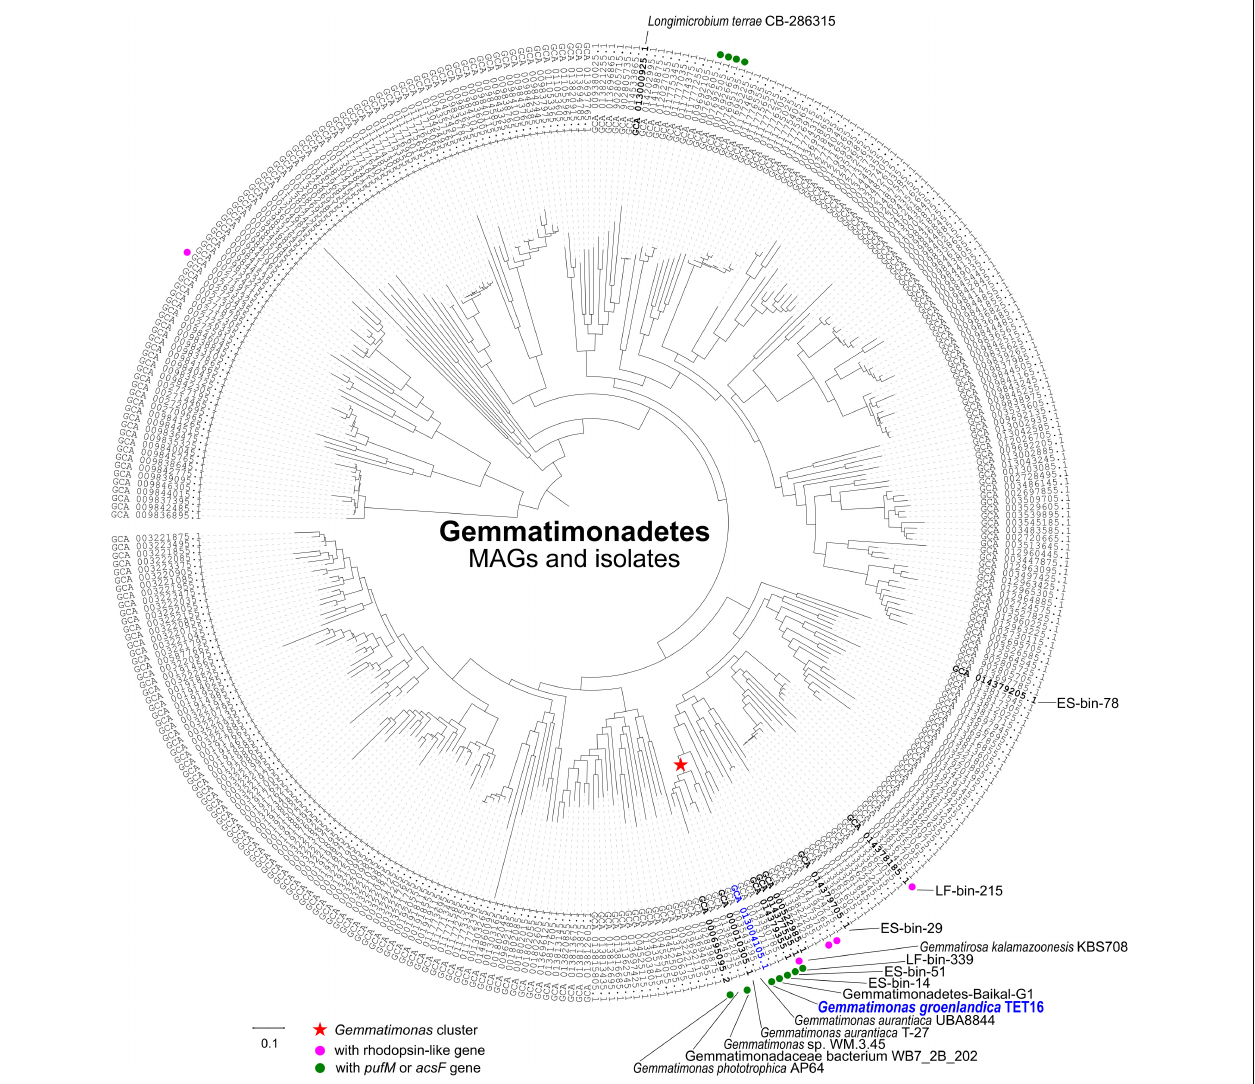
FIGURE 3 | A maximum likelihood phylogenomic tree of the metagenome-assembled genomes (MAGs) and isolates of the phylum Gemmatimonadetes based on aligned 36,076 amino acid positions from 400 most universal marker genes (see section “Materials and Methods”). All 364 Gemmatimonadetes genomes were downloaded from the NCBI microbial genomes portal. The tree was rooted with the genome of Fibrobacter succinogenes strain S85 (GenBank assembly no. GCA 000146505.1). The Gemmatimonas cluster, type strains, and the MAGs discussed in this study were highlighted on the tree. Bar represents the amino acid substitution rate. The genomes with rhodopsin-like gene or pufM / acsF gene were marked to show the distribution of phototrophic